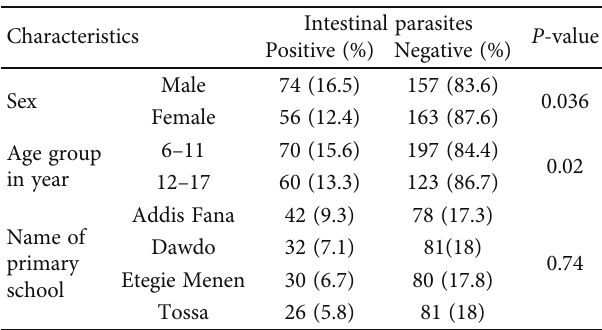
Table 3: Prevalence of IPIs among primary school children in Dessie town, North-central Ethiopia, 2021.